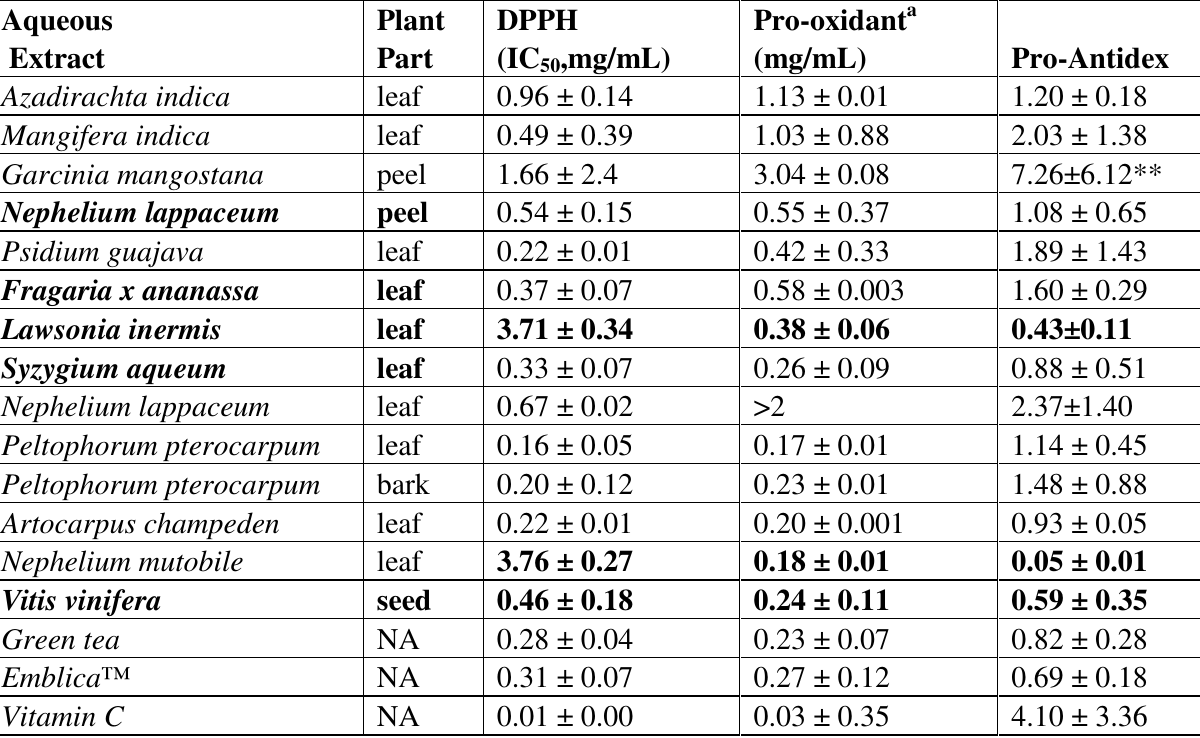
Table 2. DPPH scavenging activity, pro-oxidant and ProAntidex in aqueous extracts of selected Malaysian plants and standards. ProAntidex was devised using the ratio of pro- oxidant activities to the IC DPPH scavenging activity. All values represent means ± 50